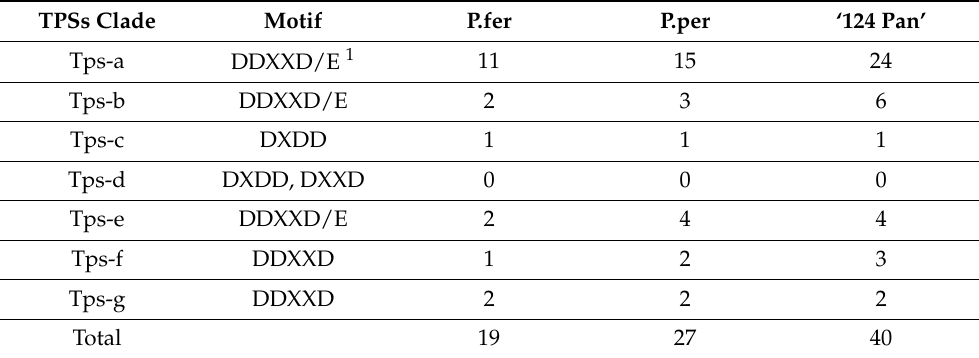
Table 6. Copy numbers of terpene synthase genes present in the peach genomes ( P. ferganensis , P. persica (Lovell), and ‘124 pan’